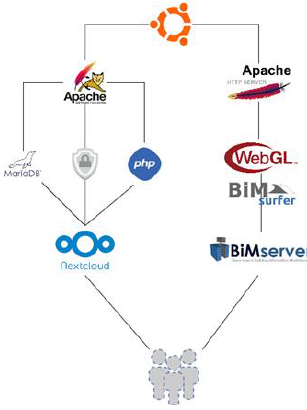
Figure 8. CloudServerBIM architecture